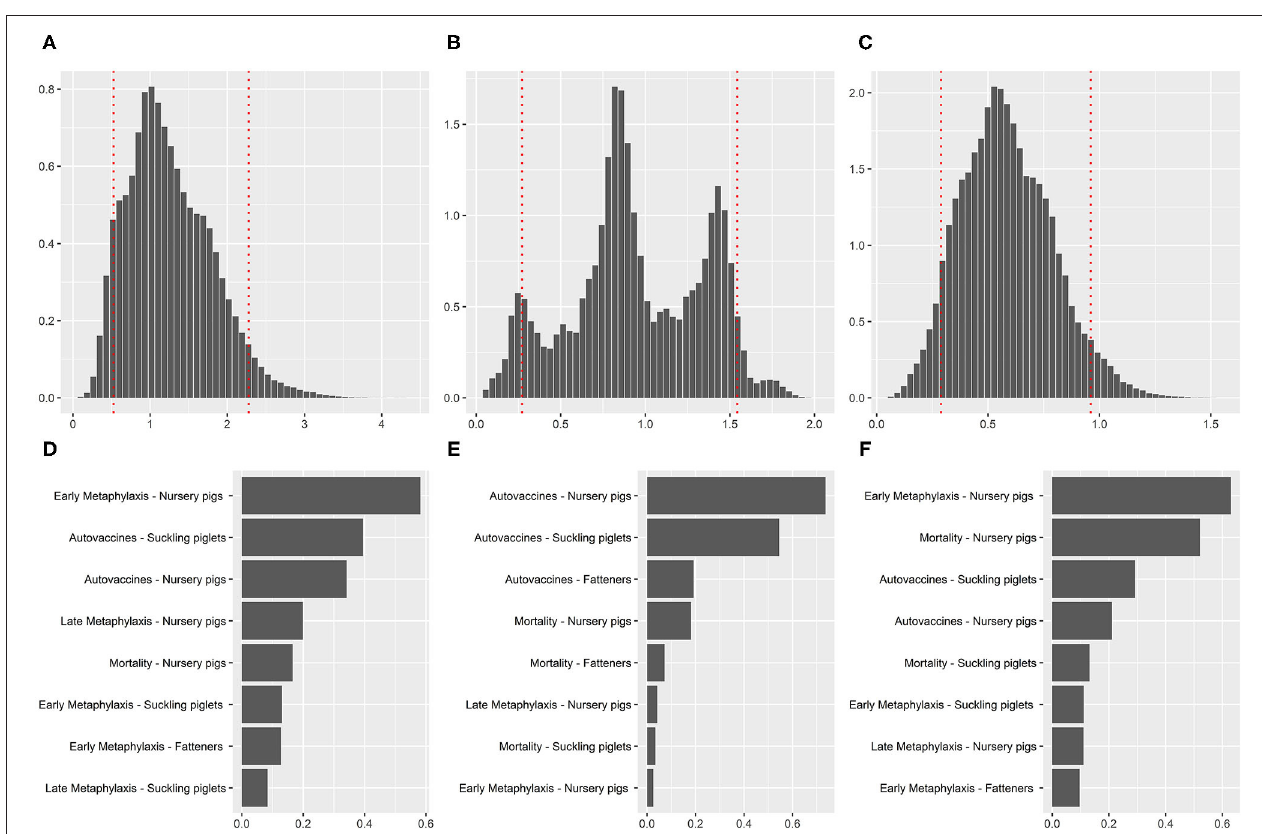
FIGURE 2 | Probability distributions for the mean cost of S. suis (summed across all production phases) per pig obtained at the end of the production cycle in Germany (A) , the Netherlands (B) and Spain (C) , and results of the sensitivity analysis of those costs (by rank order correlation) in Germany (D) , the Netherlands (E) and Spain (F)